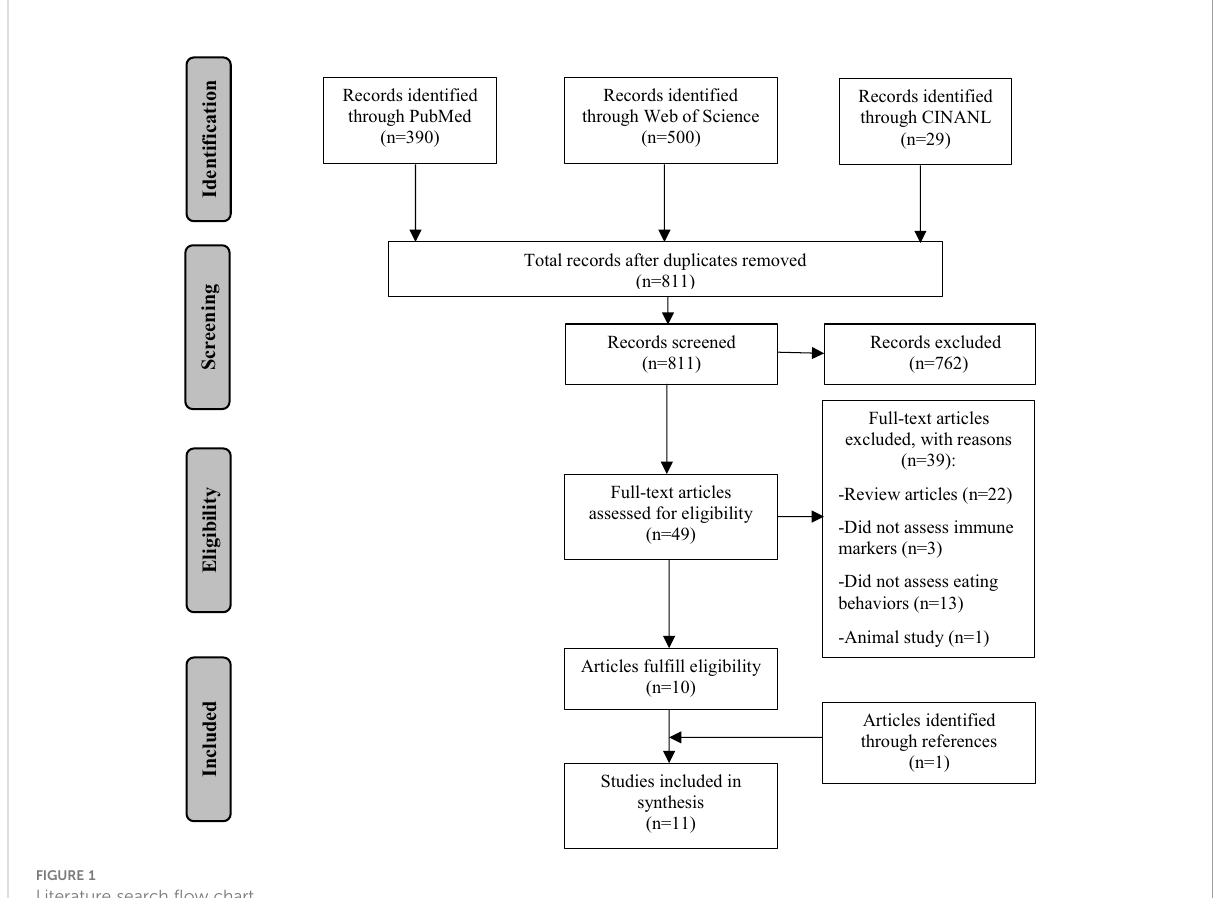
FIGURE 1 Literature search fl ow